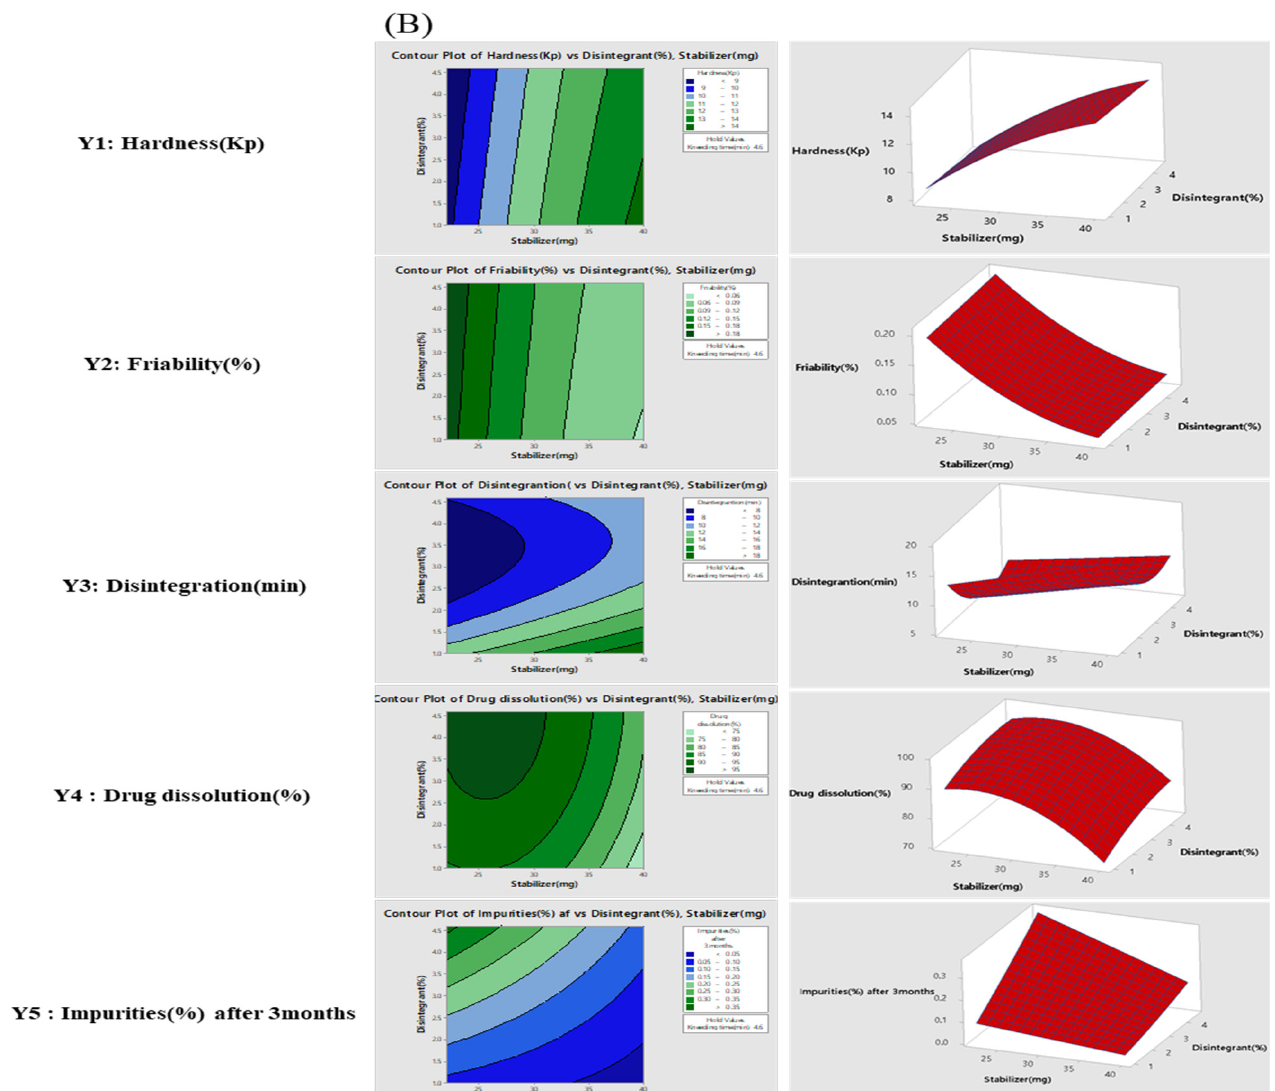
Figure 3. Effect analysis of CMAs and CPPs using contour plots and response surface plots for stabilizer and kneading time ( A ) and disintegrant and stabilizer ( B ) in the wet granulation.